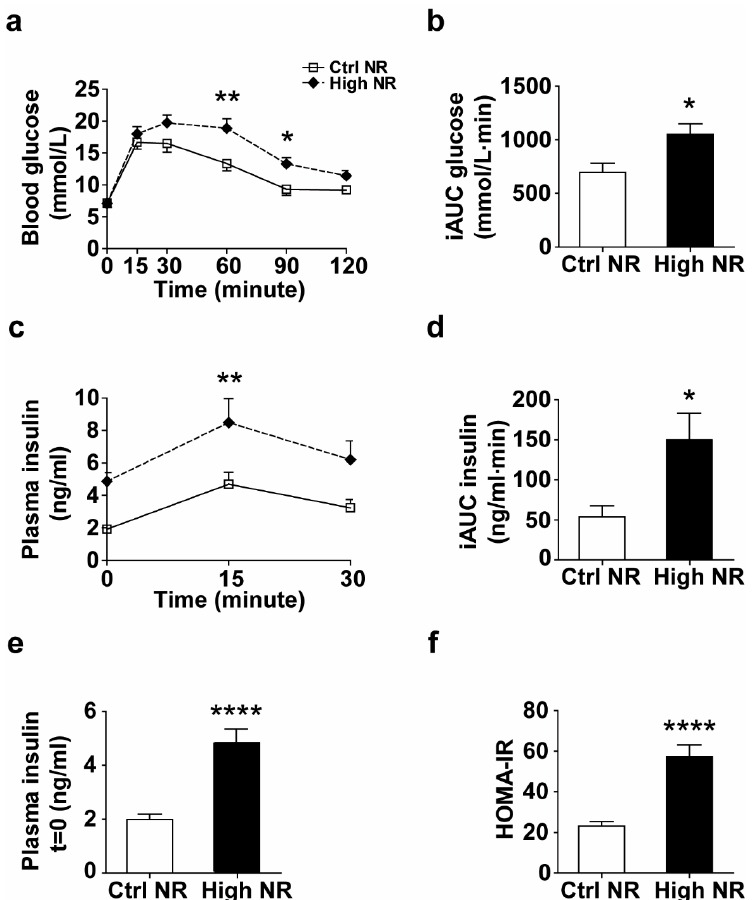
Figure 2. High NR induces lower glucose tolerance and higher circulating insulin levels during an oral glucose tolerance test (OGTT). Blood glucose was measured at indicated timepoints before and after an oral glucose administration ( a ) and iAUC was calculated to assess glucose tolerance ( b ). Plasma insulin was measured at indicated timepoints during OGTT ( c ) and iAUC (Baseline = 1.994) was analyzed ( d ). Plasma insulin at t = 0 represents fasted circulating insulin ( e ) and the corresponding HOMA-IR was calculated to assess insulin resistance ( f ). Control NR: open square with solid line or white bar; high NR: closed diamond with black dashed line or black bar. NR in mg / kg diet. Data are analyzed using either two-way repeated measures ANOVA followed by Bonferroni post-hoc analysis ( a , c ) or Student’s t -test ( b , d – f ), and presented as mean ± SEM ( n = 11–12 mice per treatment). * p < 0.05, ** p < 0.01, **** p <